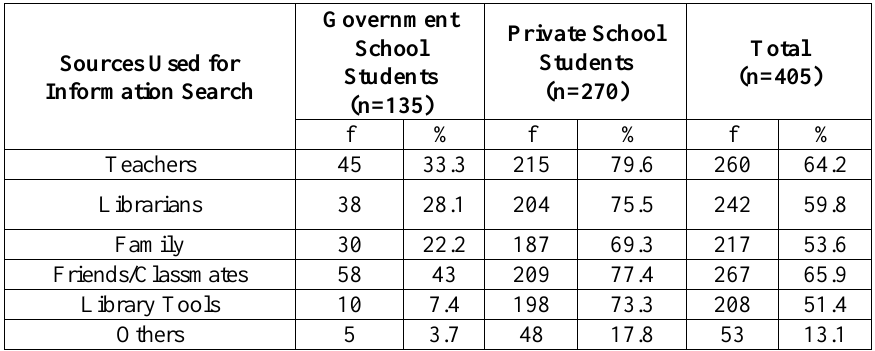
Table 1- Sources of Initiation for Seeking Information Search